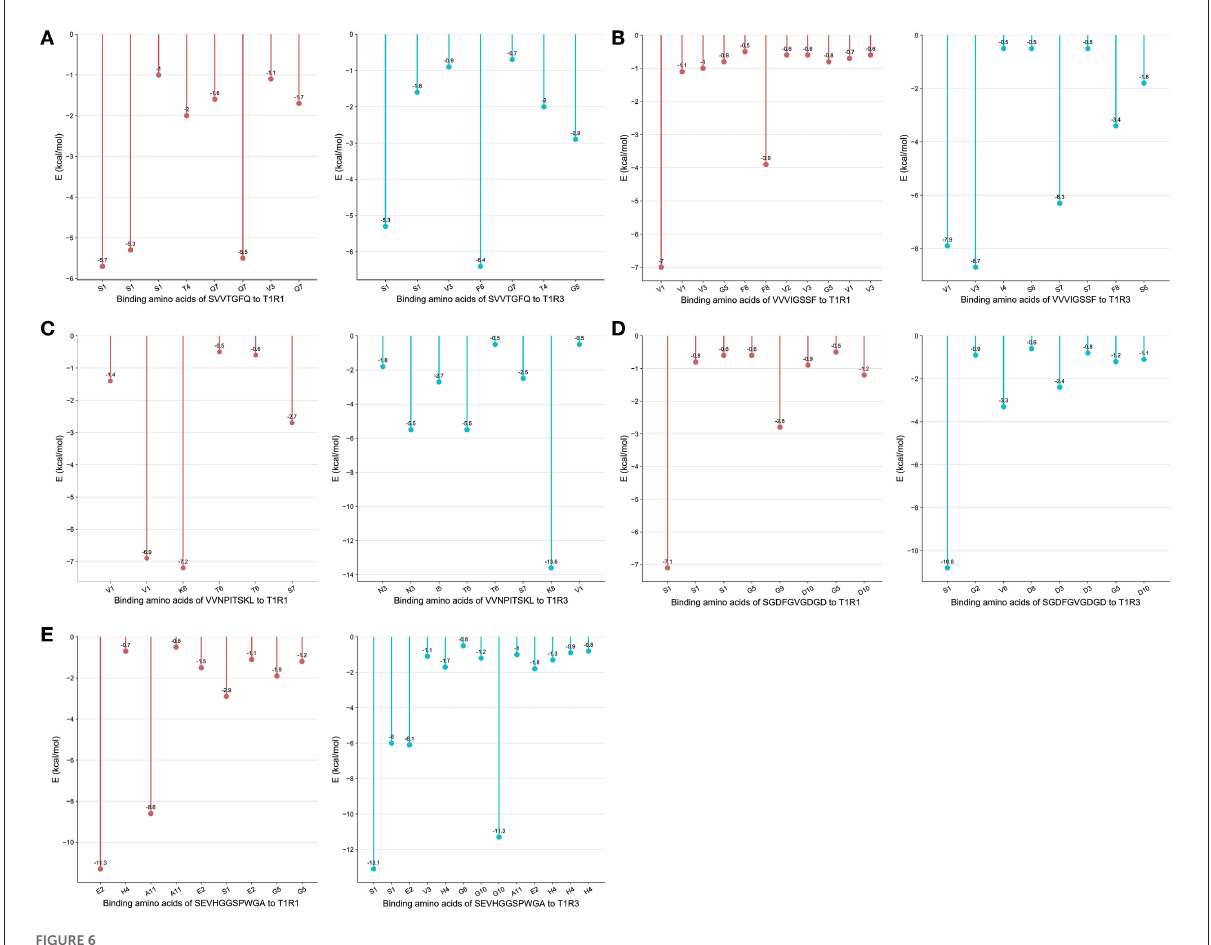
FIGURE6 (A–E) Binding amino acids of peptides to